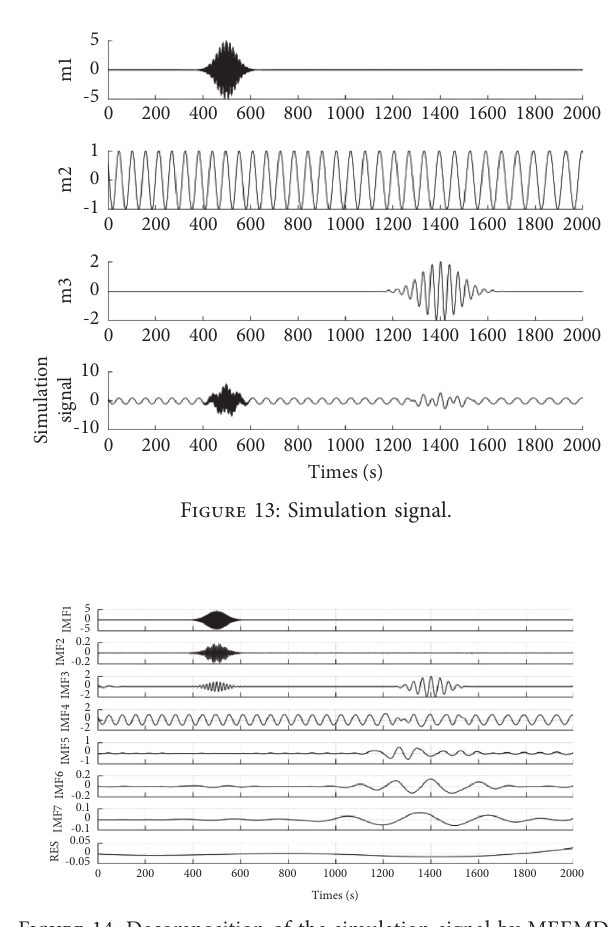
Figure 14: Decomposition of the simulation signal by MEEMD.